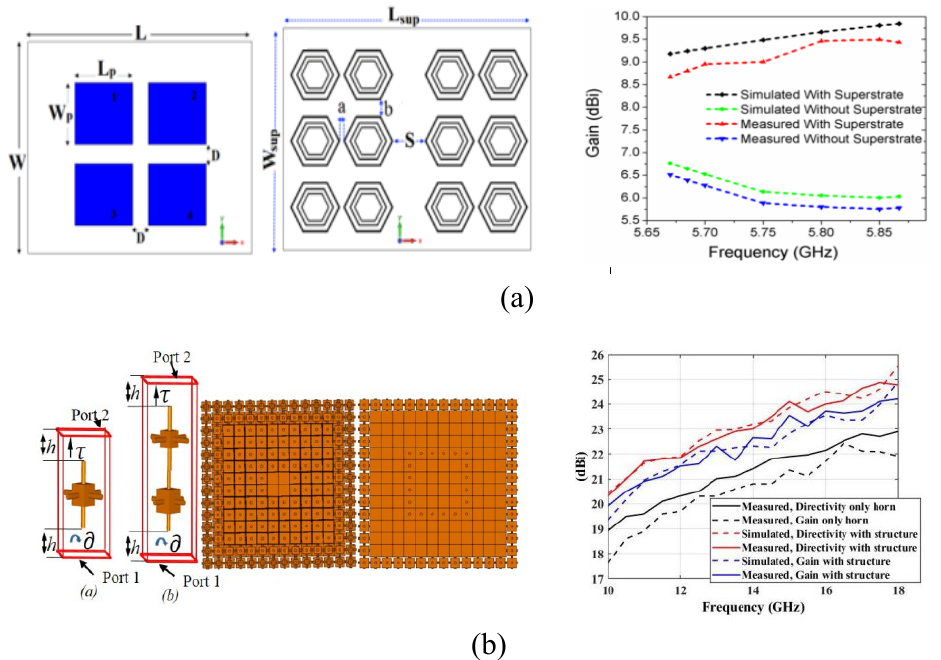
Figure 6. ( a ) Schematics of the MIMO antenna reported in [51] along with gain plot to represent variation in gain with and without metasurfaces. ( b ) Geometry of antenna in [56] with metamaterial and gain improvement plot to verify gain enhancement by single metasurface. Reprinted from Refs.